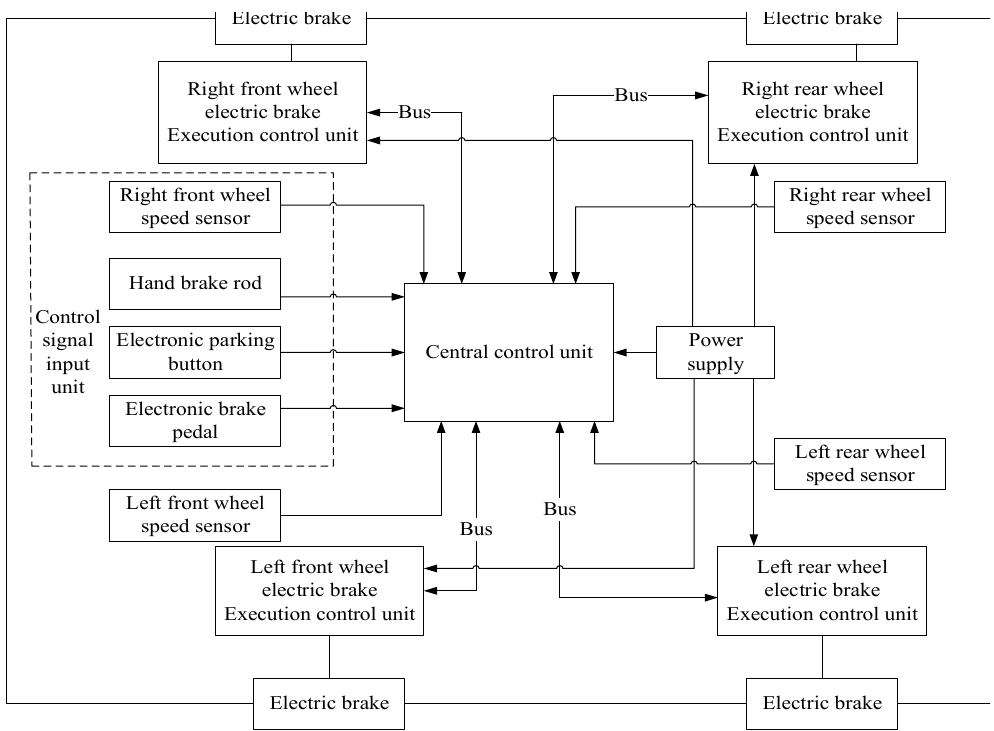
Figure 7. Hardware configuration diagram of the test platform.